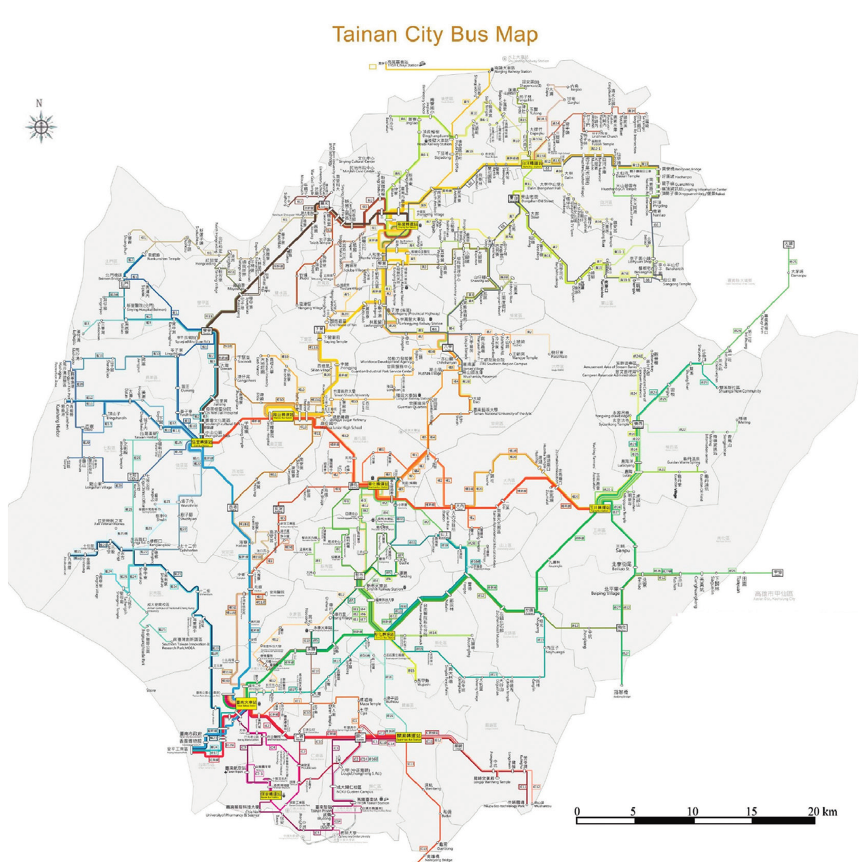
Figure 7: The bus map of Tainan City